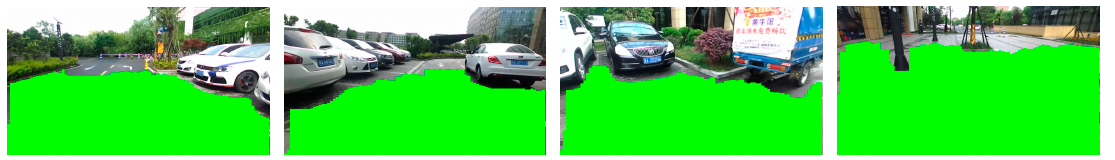
Figure 4. Traversable area detection in different scenarios.